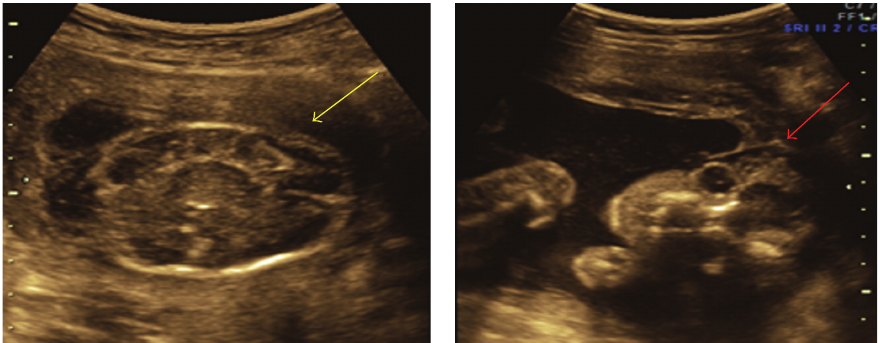
Figure 2: Deficient skull vault with membrane covering brain parenchyma.